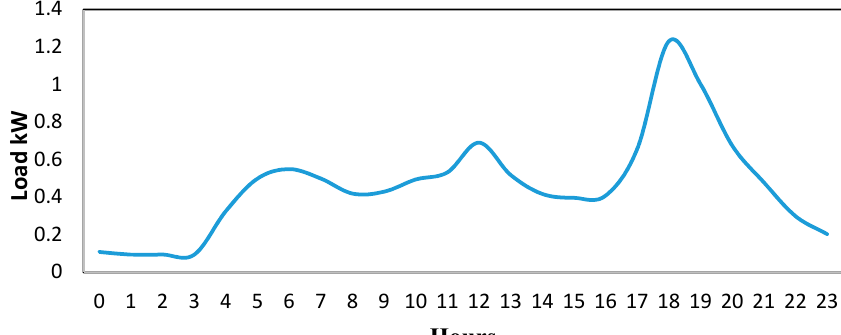
Figure 5. Energy consumption trend of a house in Aralvaimozhi on a typical day.